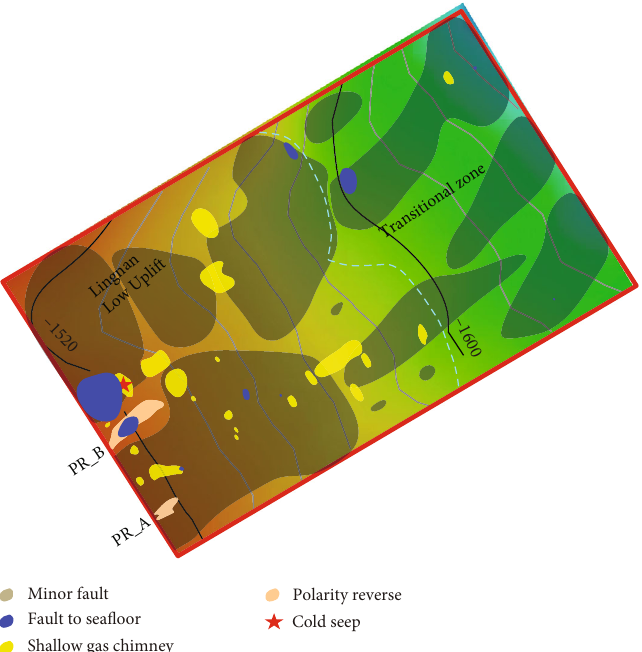
Figure 4: Distribution of the seismic anomalies in the study